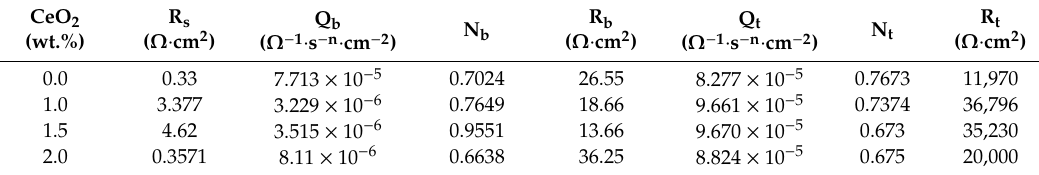
Figure 12. Impedance spectrum of coating in 3.5% NaCl solution: ( a ) Nyquist plot, ( b , c ) Bode plot, and ( d ) equivalent circuit. Table 5. EIS data of substrate and coatings with different contents of CeO 2.